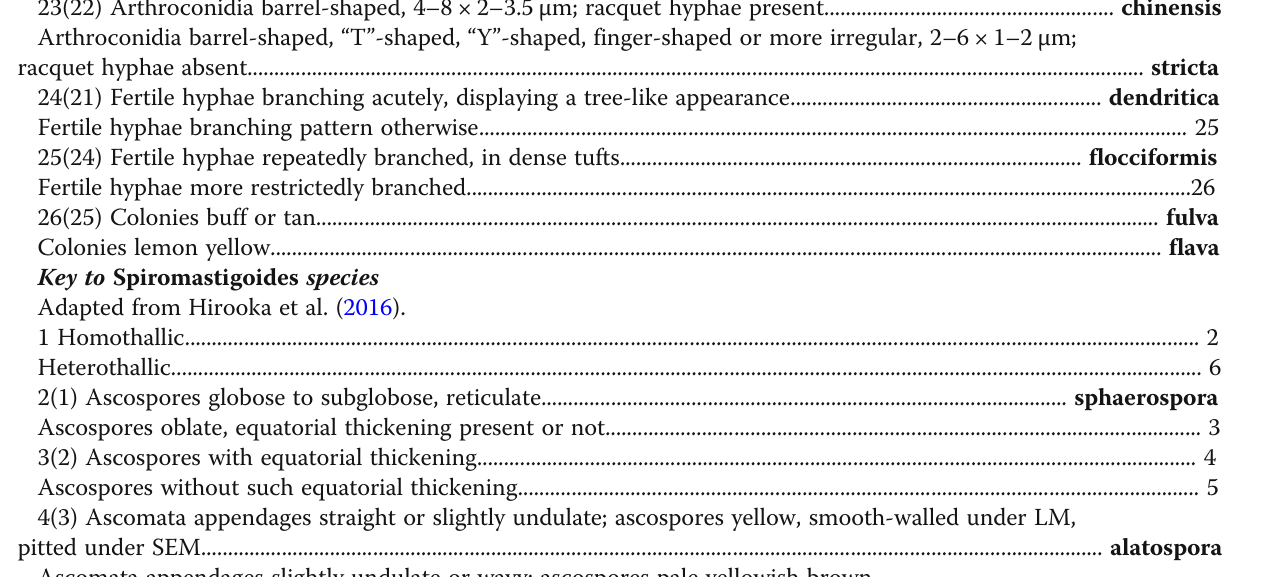
Key to Spiromastigoides species Adapted from Hirooka et al.